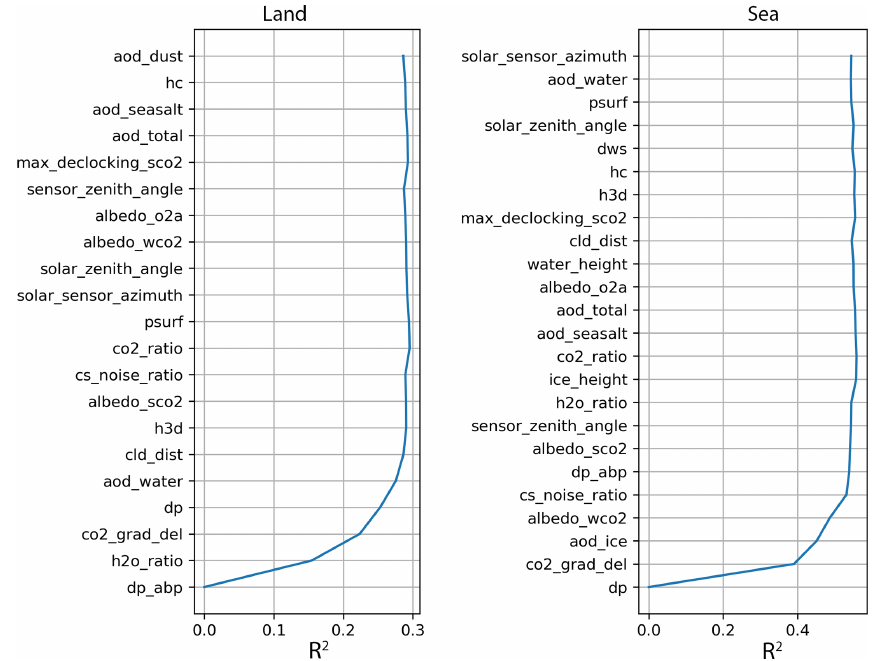
Figure 3. Feature ordering by importance as determined by recursive feature elimination. Features were removed from top to bottom, with the most important features on the bottom. The model performance for removing a given feature is indicated by R 2 calculated on the validation set. Please refer to p. 29 to 40 in Jet Propulsion Laboratory (2018) for a description of the individual features. Table 3. RMSE of X CO as determined by small-area analysis for the testing set (August 2018–July 2019). The RMSE is shown for the 2 as the proposed approach (OCO-2 lin. corr.), and a random forest using dedicated cloud metrics (OCO-2 cloud corr.). The data are separated by high-quality data (QF = 0), low-quality data (QF = 1), and all data (QF = 0 + 1). Land X CO 2